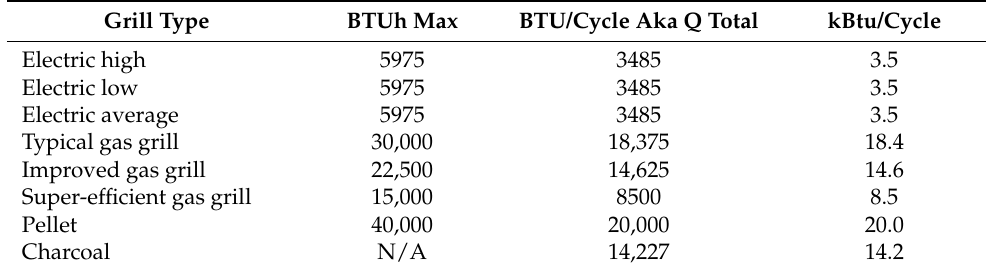
Table 6. Heat fluxes, by grill